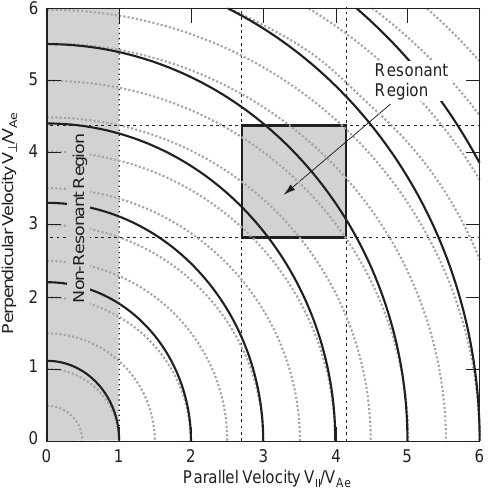
Fig. 7. The resonant electron velocity space as inferred from observations. The velocities are in units of the electron Alfve´ n velocity, v Ae . The vertical dashed line at v (cid:136) 1 is the low energy k boundary of the whistler resonance. The grey box shows the resonant region of electrons responsible for the emission of whistler waves. The solid ellipses are the iso-density contours of the weakly anisotropic electron distribution. The light circles show an isotropic distribution for comparison. Resonance takes place only in the narrow resonance region. As discussed in the text, nonlinear interaction may lead to the evolution of some residual bulge (not shown) in the resonant region which would be responsible for the observed emission